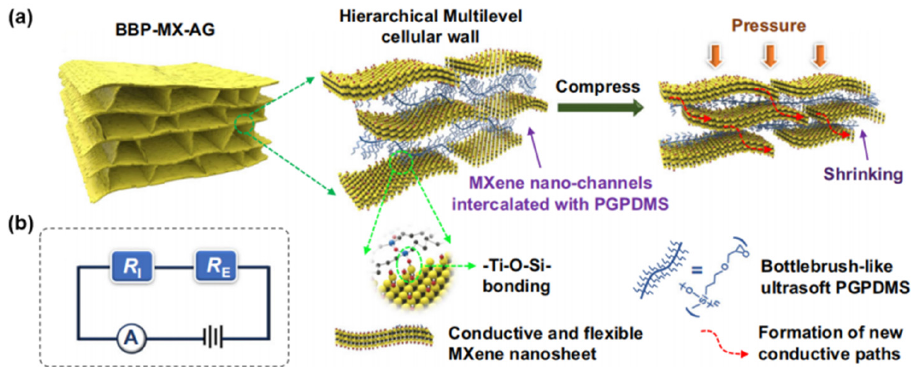
Figure 14. ( a ) Schematic diagram of the wireless device and signal codes. ( b ) Morse code signals represent different words. Reproduced with permission from ref. [148]. Copyright 2022, Elsevier.